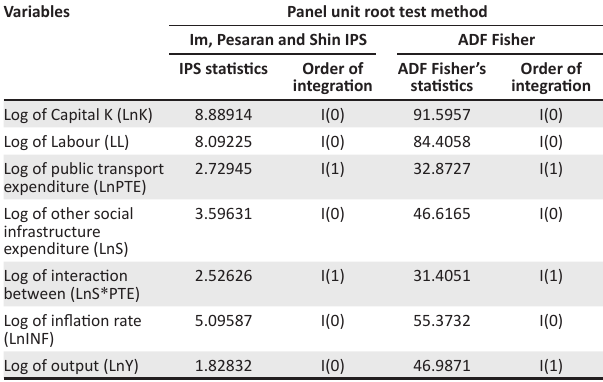
TABLE 2: Im, Pesaran and Shin IPS, augmented Dickey–Fuller test.